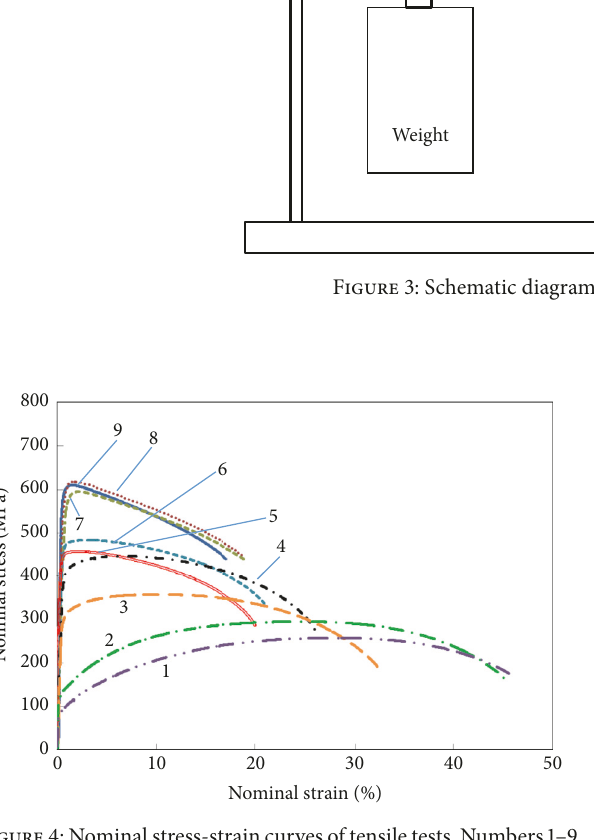
Figure 4: Nominal stress-strain curves of tensile tests. Numbers 1–9 correspond to the sample numbers in Table